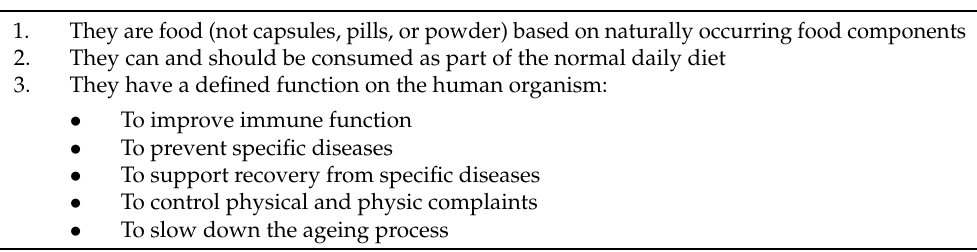
Table 1. The Japanese FOSHU criteria for functional food.